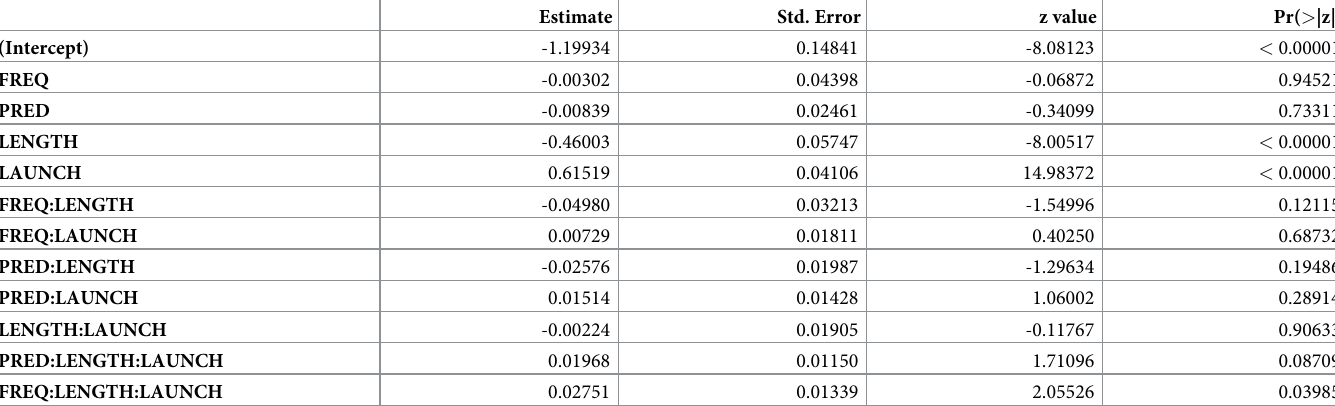
Table 3. Fixed effects of optimal GLMM (Model 2) for the probability of skipping the test words.